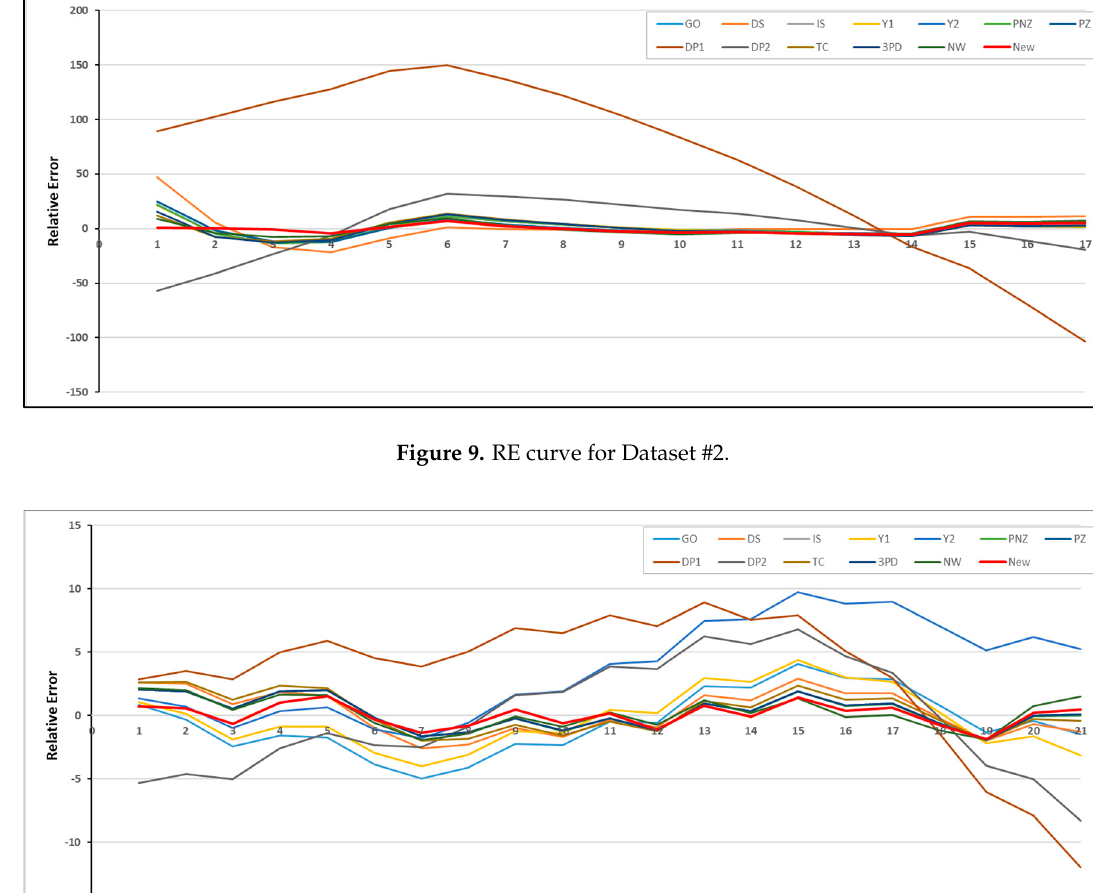
Figure 10. RE curve for Dataset #3.